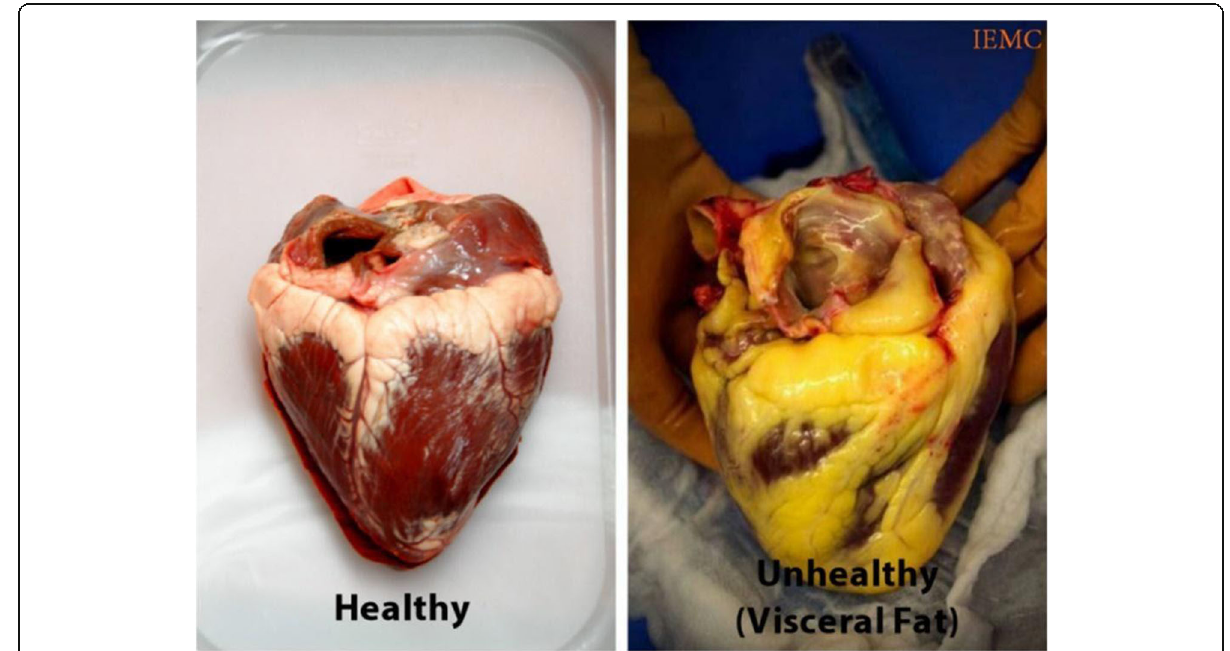
Fig. 2 Healthy heart vs. unhealthy heart with excess